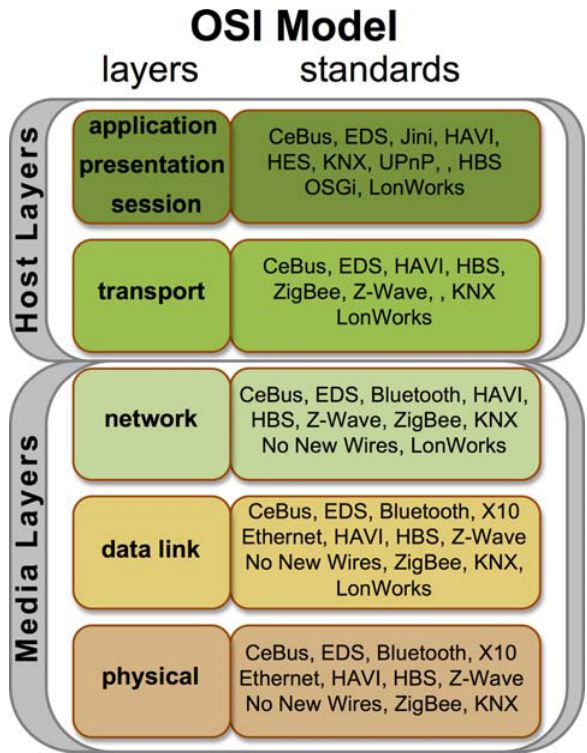
Figure 1. Classification of domotic standard according to the ISO/OSI